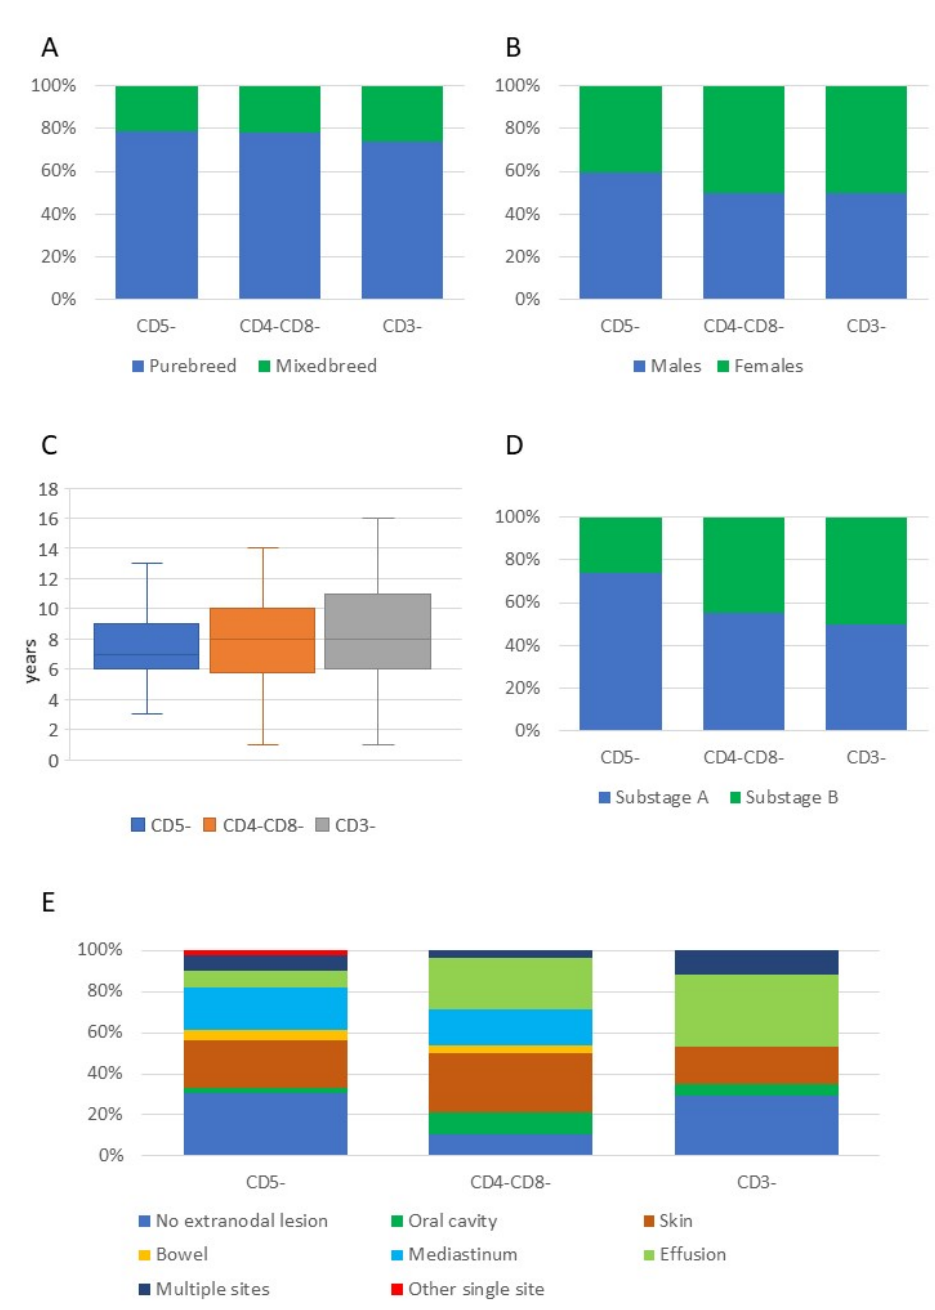
Figure 1. Breed ( A ), sex ( B ), age ( C ), substage ( D ), and presence of extranodal lesions ( E ) in 152 dogs with T-cell lymphoma not otherwise specified, according to the three most common phenotypic aberrancies.